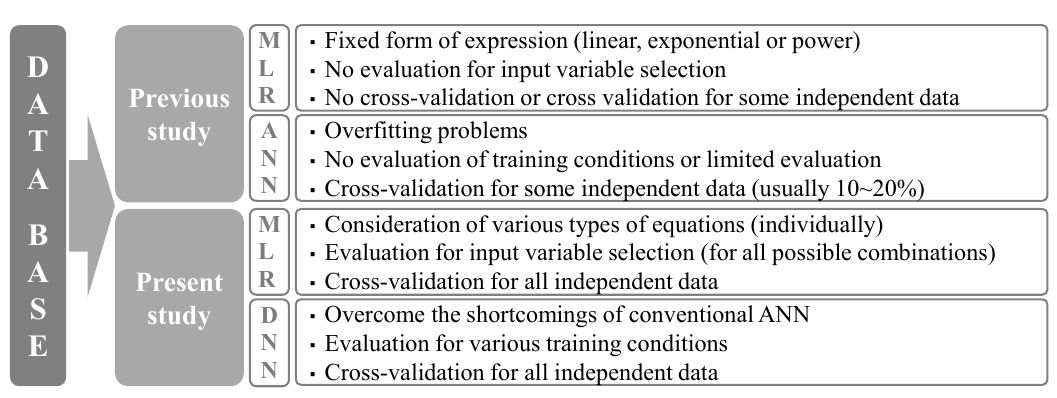
Figure 5. Comparison of modeling approaches between previous and present studies.